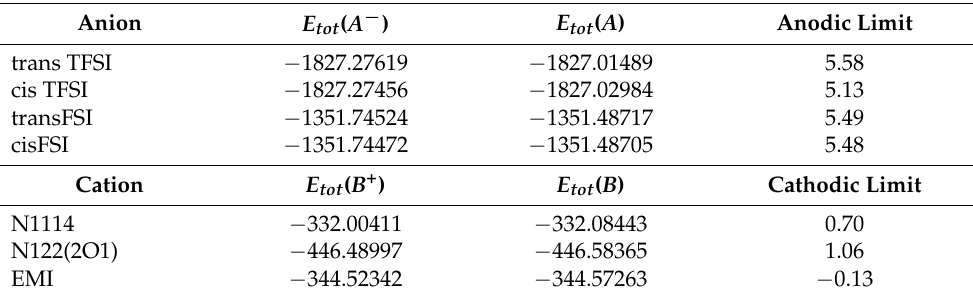
Table 7. Gibbs energy (in atomic units) of anions and cations and their relaxed neutral forms calculated at the B3LYP/6-31G** level of theory in the presence of a polar medium and derived anodic or cathodic limit (V).